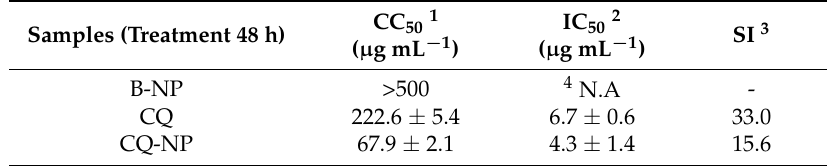
Table 3. Cytotoxicity and parameters of anti-HSV-1 activity evaluated for chloroquine (CQ), blank PLA nanoparticles (B-NP) and chloroquine-loaded PLA nanoparticles (CQ-NP) in Vero E6